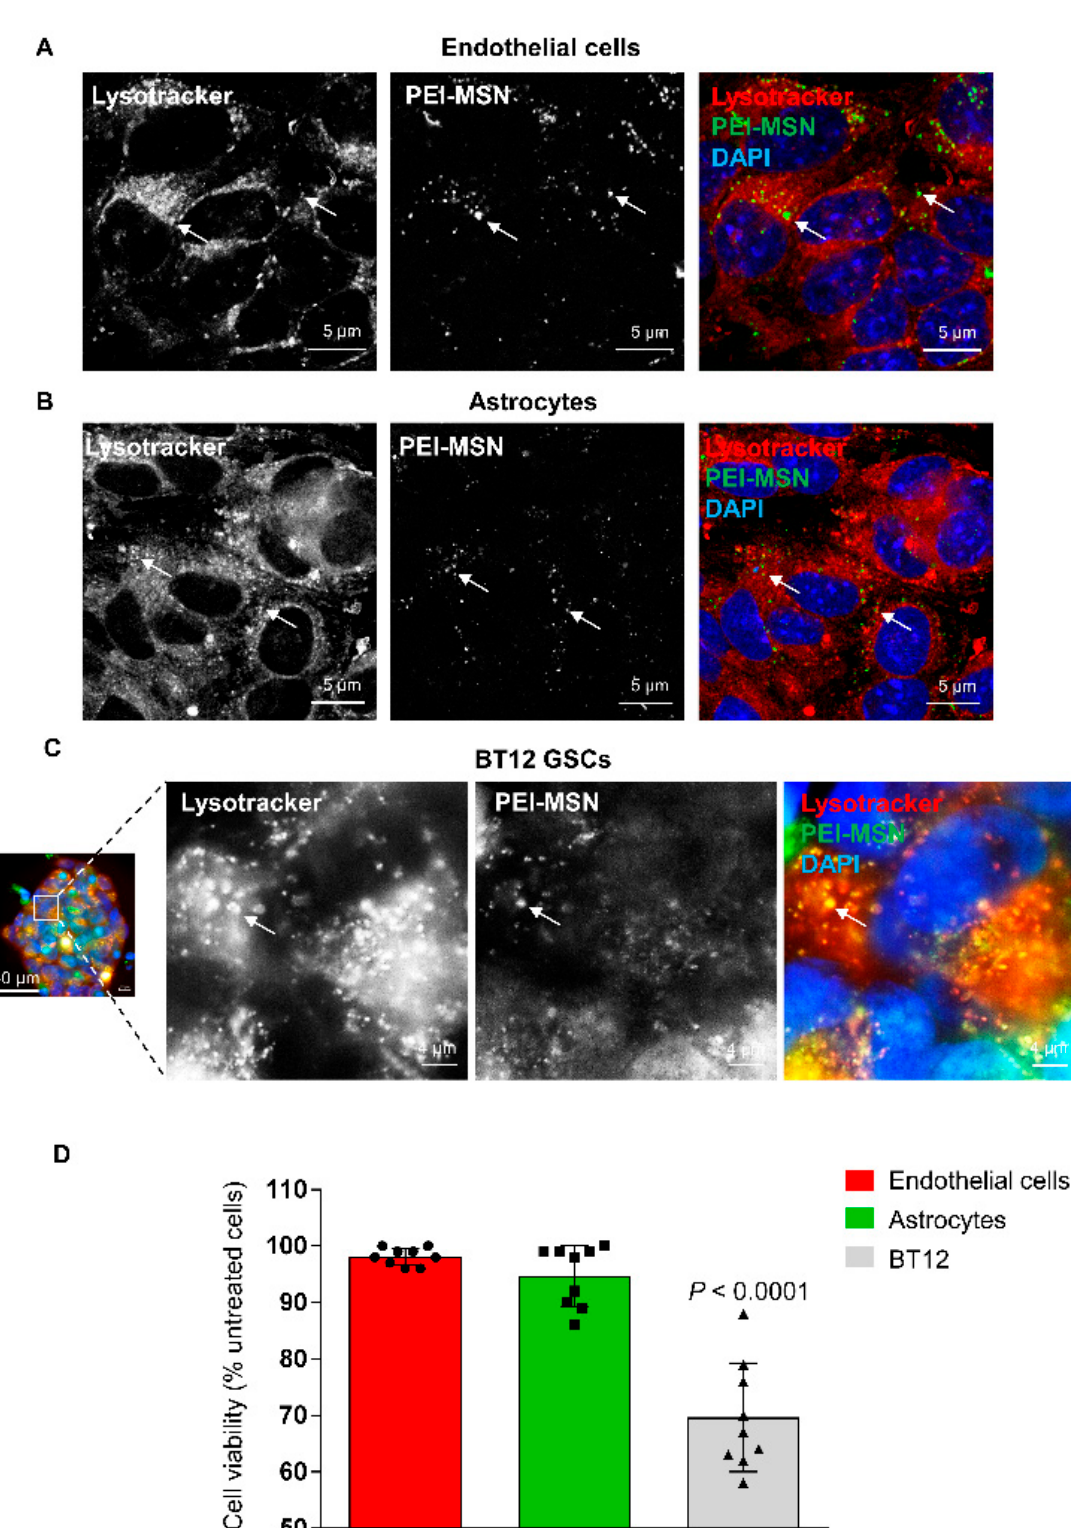
Figure 9. The PEI-MSNs cross the BBTB in vitro. ( A – C ) Confocal images of the colocalization of PEI-MSN (green) with the Lysotracker dye (red) in the endothelial ( A ), astrocytic ( B ), and GSC ( C ) compartments 24 h after addition of the PEI-MSN. Images in ( C ) are magnified from a BT-12 gliosphere (squared region of interest on the left panel). ( D ) Cell viability measured by MTT after 72 h. Values are normalized to the control conditions (cells isolated from untreated BBTB). n = 3, three pooled experiments. p -value calculated with one-way ANOVA with Sidak’s multiple comparison test.